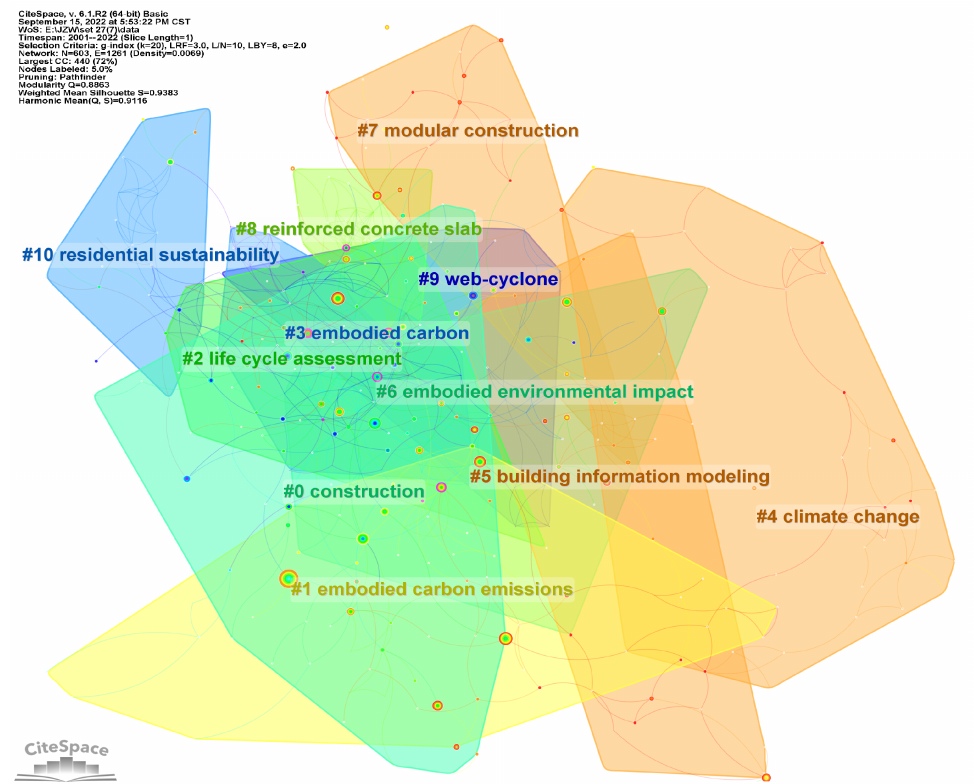
Figure 7. Cluster view of literature co-citation